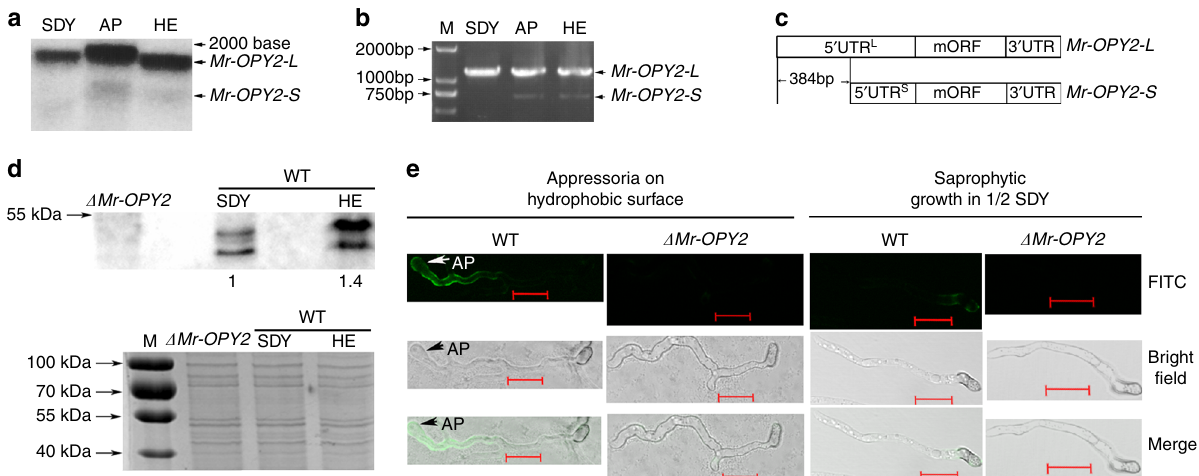
Fig. 2 Transcription and translation analyses of the Mr-OPY2 gene. a Representative Northern blot image of RNA isolated from undifferentiated mycelia grown in SDY or hemolymph (HE), and from germlings differentiating appressoria on locust wings (AP). The uncropped Northern blot is shown in Supplementary Fig. 11a. b 5 ′ RACE with the RLM RT-PCR kit. The uncropped image of the agarose gel is shown in Supplementary Fig. 11b. c A diagrammatic representation of differences between the two mRNA variants of Mr-OPY2 . Note: the two transcripts share the same major ORF but they have different 5 ′ UTR. d Representative western blot image and analysis to quantify Mr-OPY2 levels in Δ Mr-OPY2 and WT grown in SDY or hemolymph (HE) (Upper panel). The OPY2 levels of hemolymph-grown WT mycelium (1.4) is calculated relative to growth in SDY which is set at 1. Δ Mr-OPY2 is included as a negative control. Lower panel: a portion of the loading control gel (for the Western blot analysis in upper panel) stained with Coomassie Brilliant Blue. M: Protein ladder (Thermo scienti fi c, USA). The uncropped images of the western blot and the SDS-PAGE gel are shown in Supplementary Fig. 11c, d. e Immunohistochemical staining of the Mr-OPY2 protein in germlings differentiating appressoria against a plastic surface, and in non-differentiating germlings from 1/2 SDY shake cultures. Scale bar represents 10 μ m. FITC: Fluorescein isothiocyanate; Merge: FITC and bright fi eld pictures are merged;